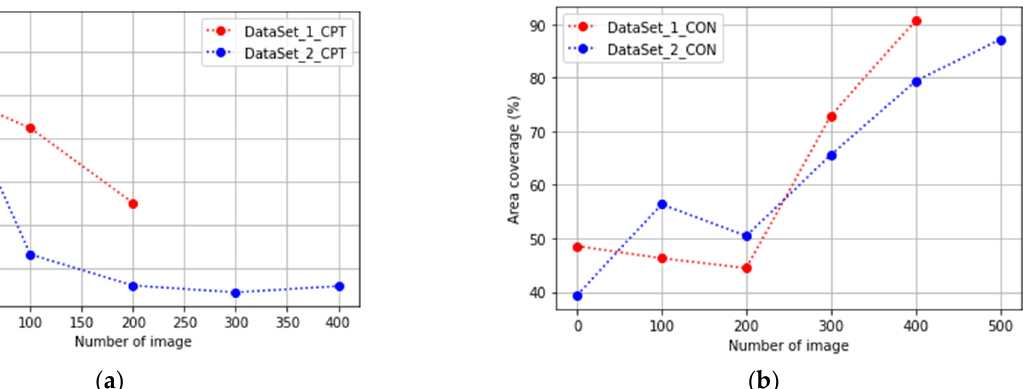
Figure 7. Gold Standard values: percentages of cells obtained with manual segmentation. ( a ) Evolution of cells to the confluency stage; ( b ) cells injected with CPT to generate the apoptosis stage.